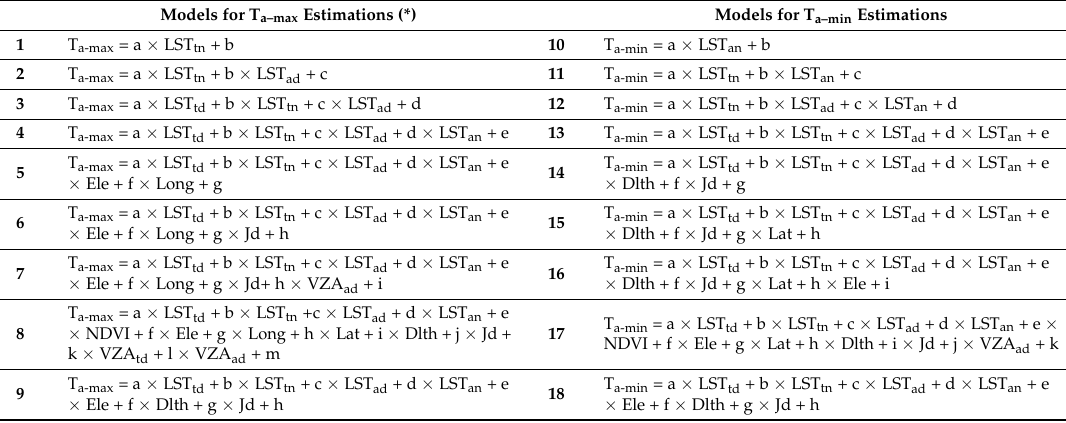
Table 5. Model equations for T a-max (1–9) and T a-min (10–18)